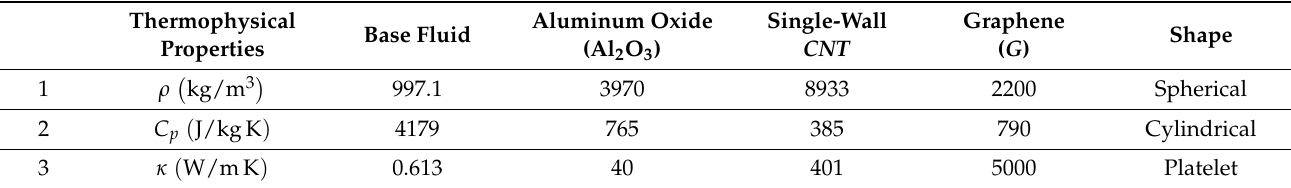
Figure 1. Physical model of the ternary hybrid nanofluid. Table 1. Thermophysical properties of different